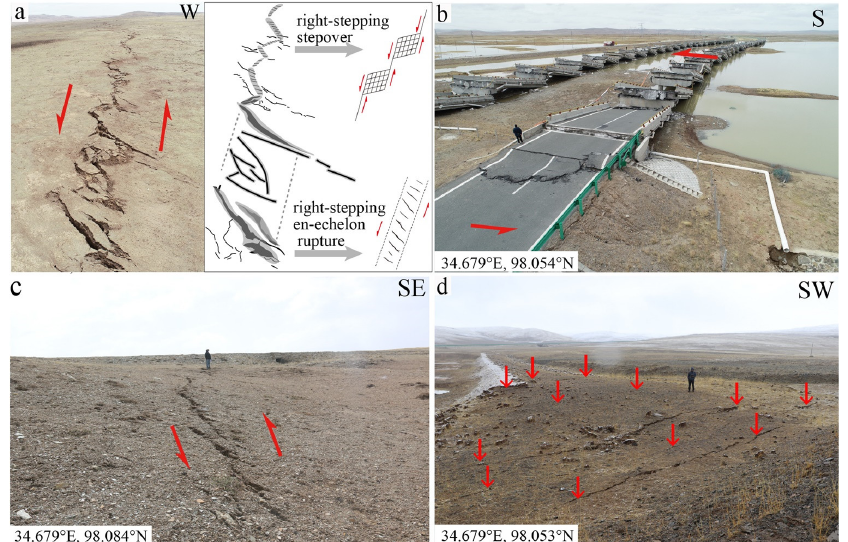
Figure 6. Representative photos of rupture at Yematan Bridge: ( a ) orthophoto and the geometry schema of right-stepping en echelon rupture close to Yematan Bridge; ( b ) collapsed Yematan Bridge; ( c ) right-stepping echelon fissures; ( d ) multiple parallel extensional cracks along the rupture close to the Yematan Bridge.